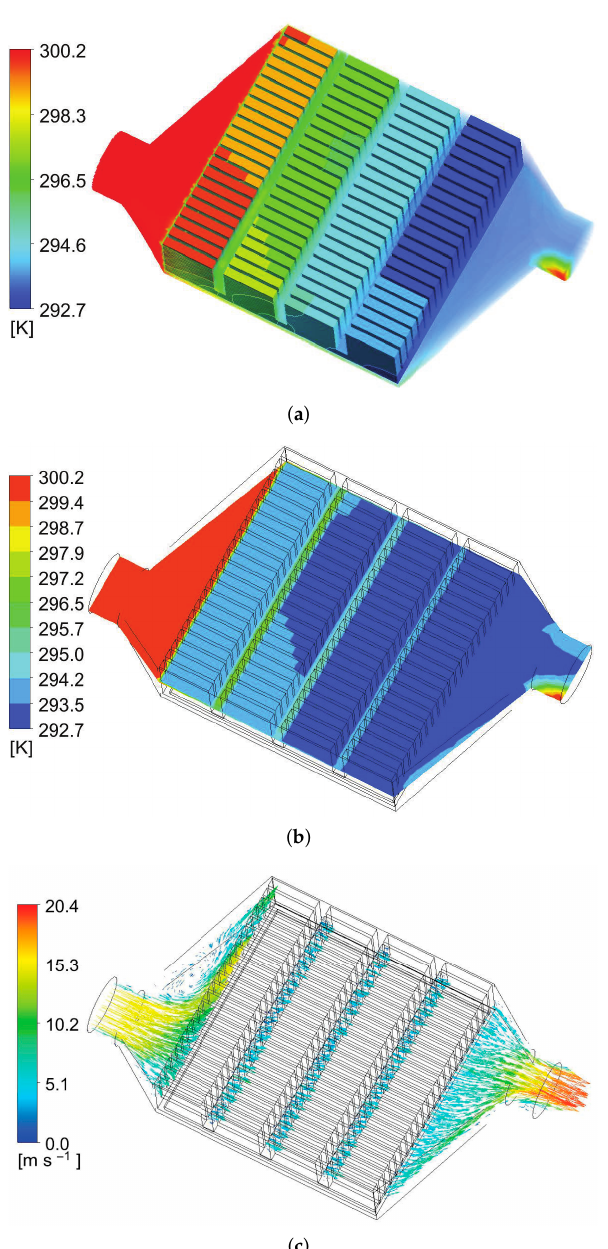
Figure 10. CFD simulation effects for candidate point: ( a ) temperature distribution inside the cavity; ( b ) temperature distribution at the height of 6 mm; ( c ) airflow velocity distribution at the height of 6